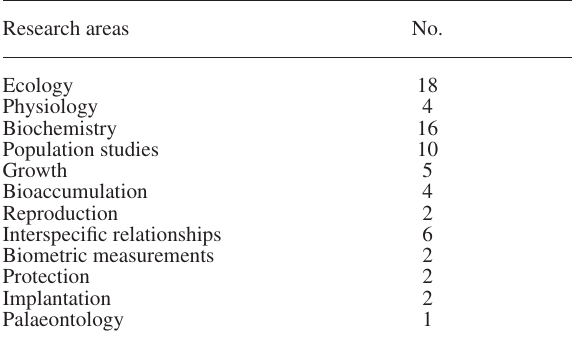
Table 1. − number of studies on P. nobilis in particular research areas (source: AsfA; zoological records; 1978-2007). research